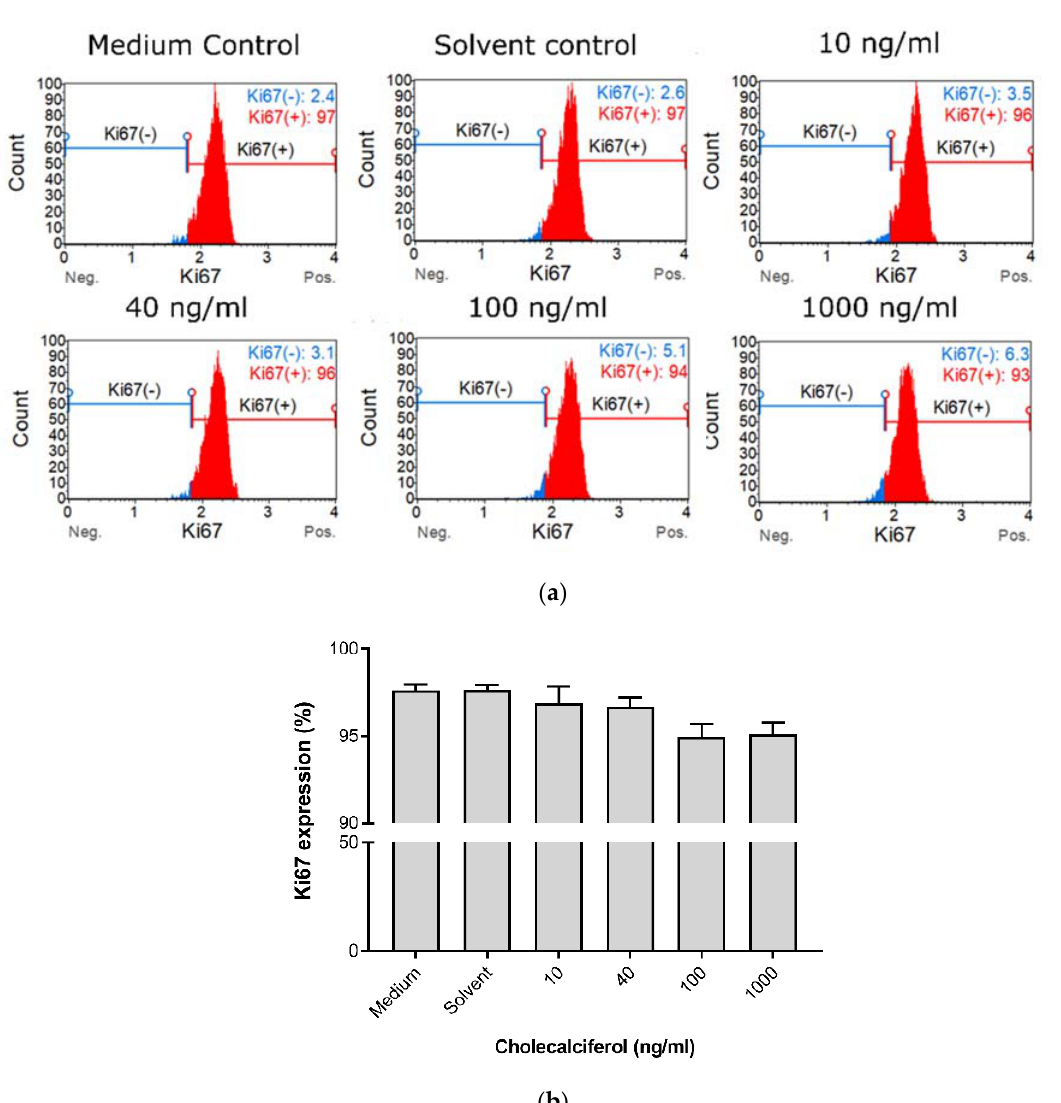
Figure 2. Cell proliferation measured by Ki67 nuclear antigen expression in the cholecalciferol control and experimental CaSki cultures. ( a ) Histogram of Ki67 expression in the control and experimental CaSki cultures. ( b ) Ki67 expression in the control and experimental CaSki cultures. Cholecalciferol did not cause statistical changes in cell proliferation between the control and experimental cultures. The analysis was performed in triplicate on three biological repeats. Values are expressed as mean ± SEM ( p < 0.05 was considered statistically significant).